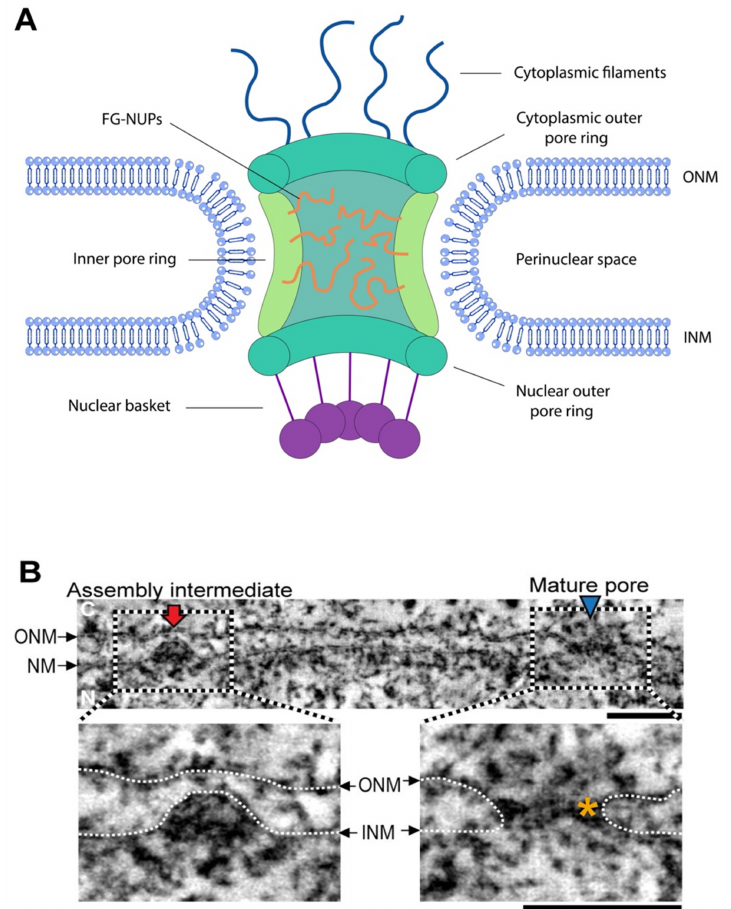
Figure 1. (Ultra)structural characteristics of the nuclear pore and its assembly intermediates ( A ) Schematic representation of the nuclear pore complex (NPC) embedded into the nuclear en- velope. ( B ) Electron-tomographic slice of a region of an isolated nuclear envelope (NE) of HeLa cells. An assembly intermediate (i.e., a dome-shaped evagination of the INM) and a mature pore are indicated by a red arrow and a blue arrowhead, respectively. The highly curved pore membrane domain is indicated by an orange asterisk. ONM, outer nuclear membrane; INM, inner nuclear membrane. Scale bar = 100 nm. Reprinted and adapted from